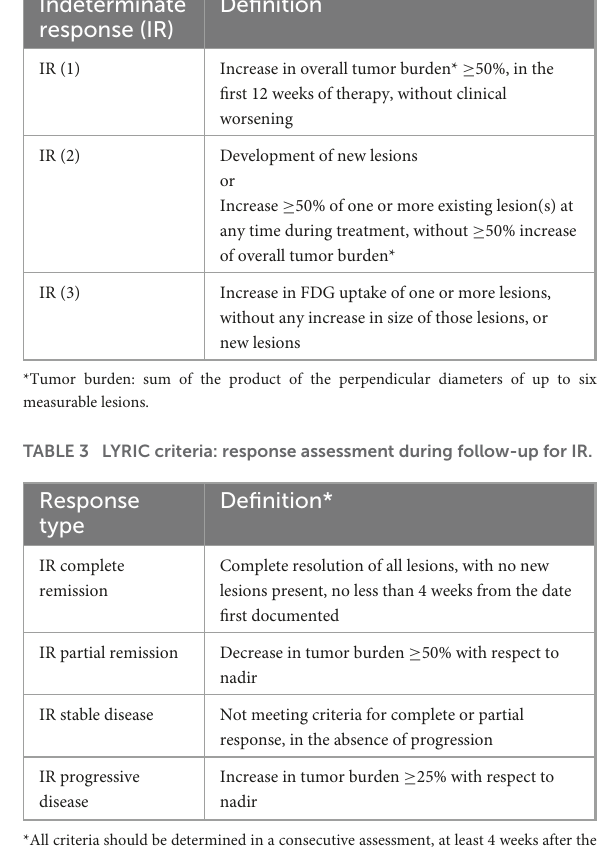
TABLE 2 LYRIC criteria, definitions for indeterminate response (IR) category. Indeterminate response (IR)